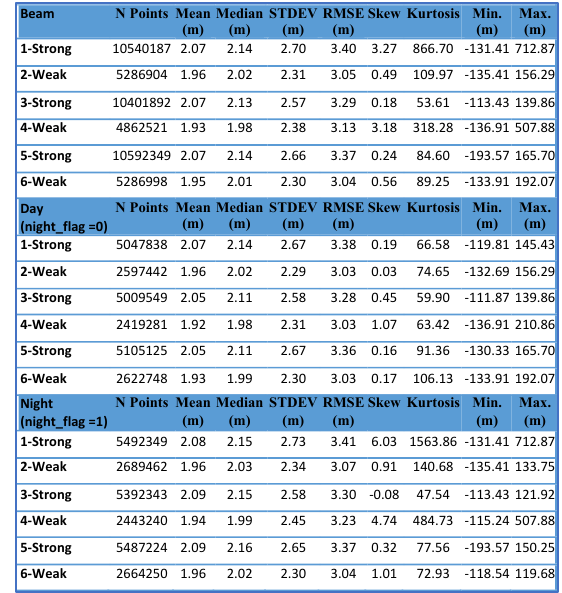
Table 8. Statistics for elevation differences SRTM90